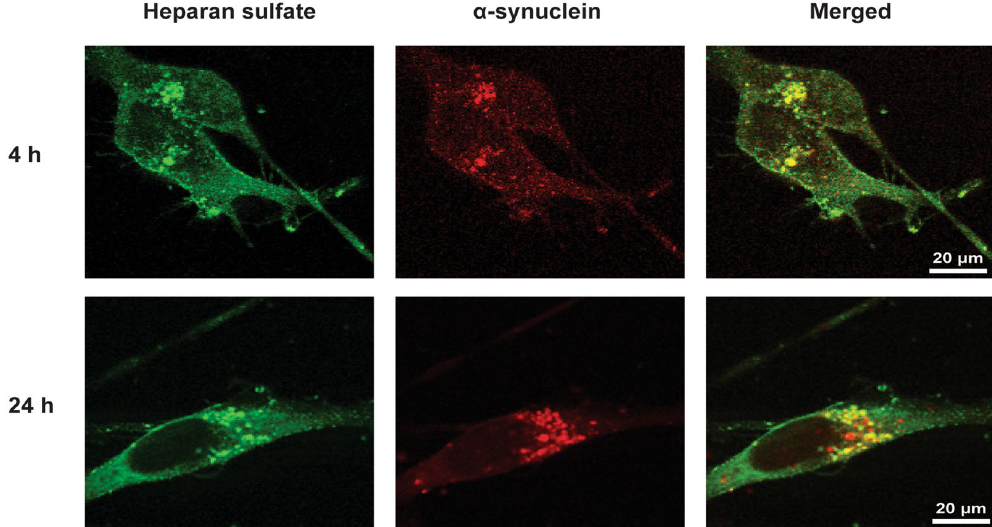
Figure 3. Colocalization of α -synuclein amyloid fibrils and heparan sulfate in B103 cells. Alpha-synuclein fibrils were labeled with AlexaFluor594 and added to the cell media. Cells were fixed at various time-points after α -synuclein addition, and thereafter stained with the anti-heparan sulfate antibody 10E4 and visualized with confocal